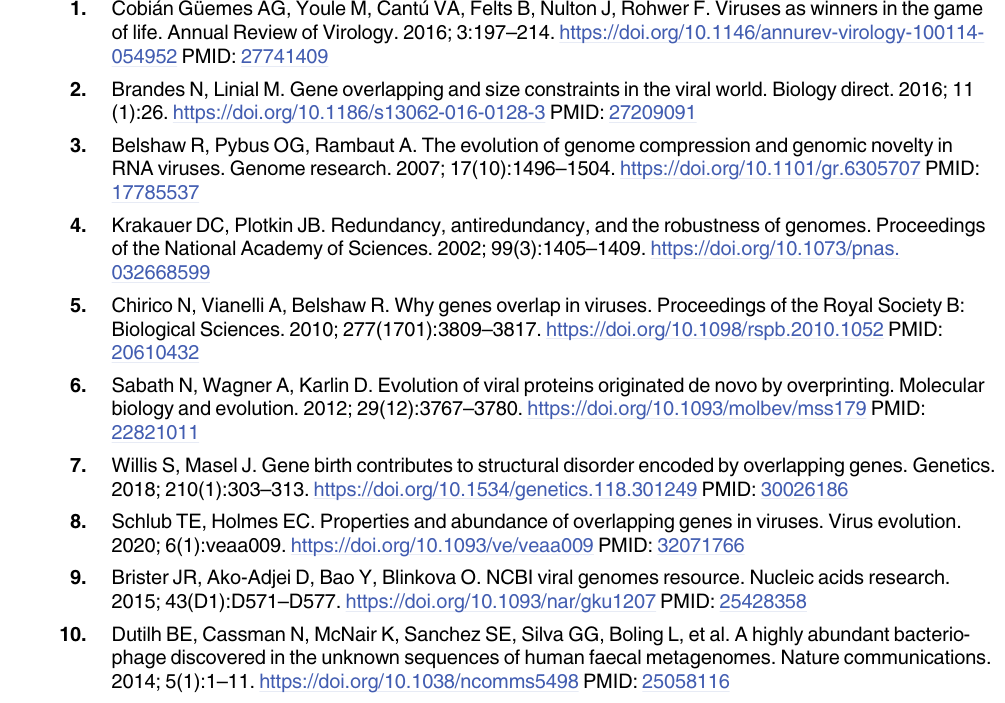
S11 Fig. Adjacency graph of Adenoviridae family with overlapping edges proportional to overlap